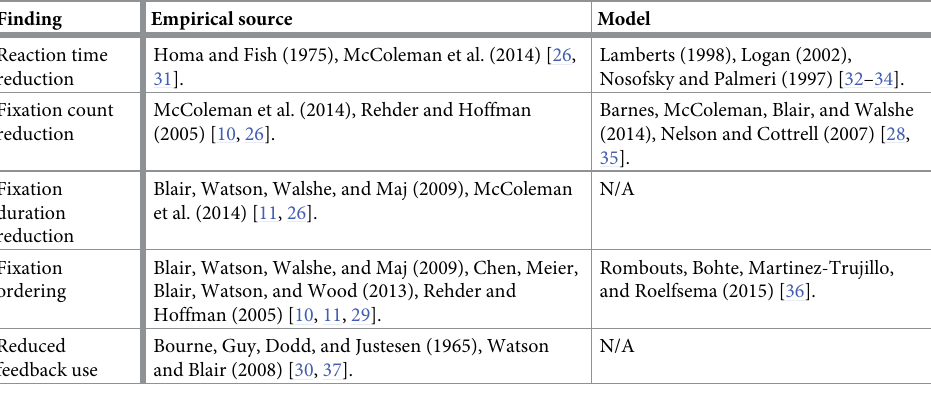
Table 1. Eye tracking, timing and category learning